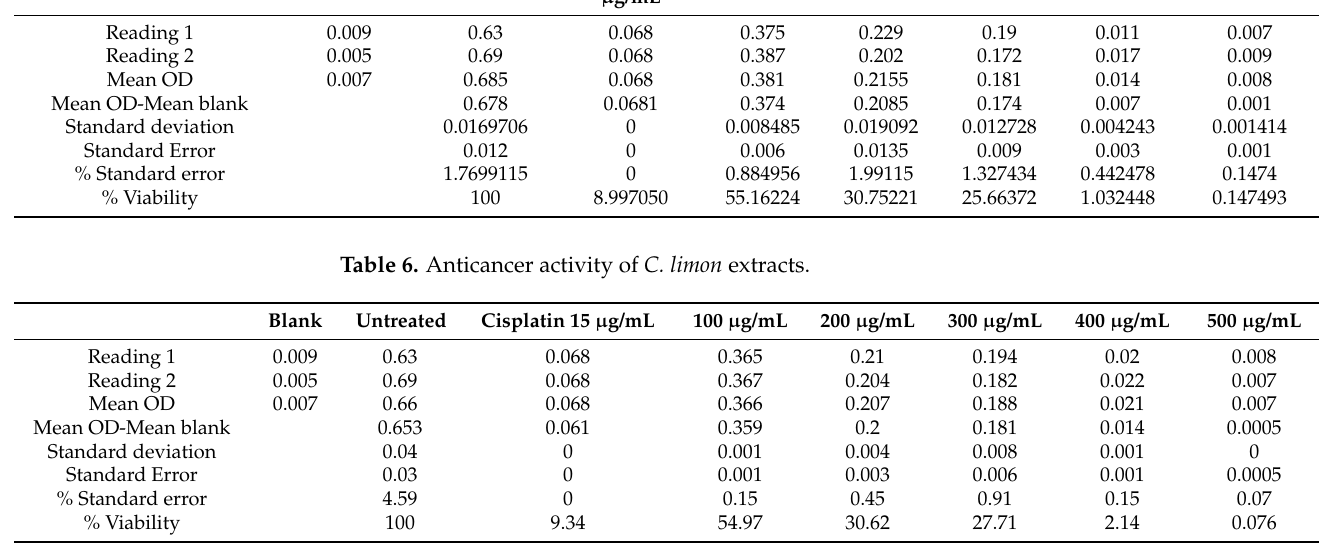
Table 5. Anticancer activity of A. concinna extract.